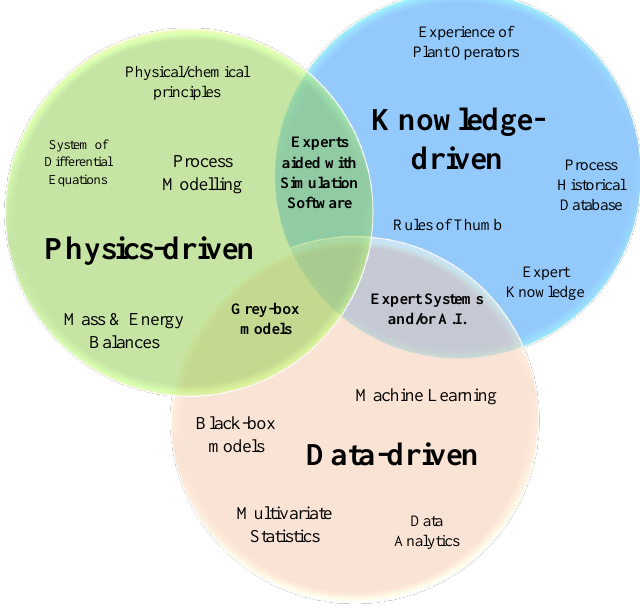
Figure 1. Three categories of process monitoring methods. See [1,6] for more